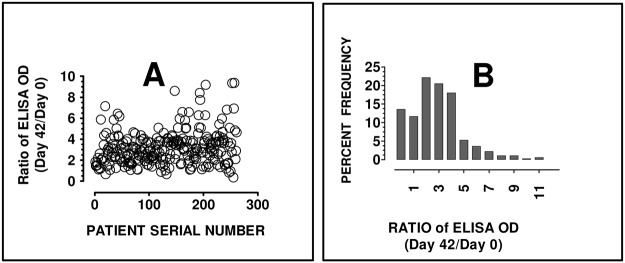
Fold increase in post-infection serum anti-peptide IgG.Sera obtained at diagnosis and 42 days later were tested by ELISA using GLURP, MSP3 and HRPII synthetic peptides as micro titer well-bound antigen coat. For each study participant, the ELISA ODs were added to produce a summative ELISA OD. A. The ratio of respective summative ELISA OD for serum collected on day 42 and day 0 (y-axis) was plotted against serial number of study subject (x–axis). ELISA OD represents IgG level while the ratio of the ELISA units for the serum drawn on the 2 days (Day 42/day 0) represents fold-increase in anti-peptide IgG. B. Histogram of the ratio (ELISA absorbance for day 42 serum/ ELISA absorbance for day 0 serum). OD: optical density or absorbance.